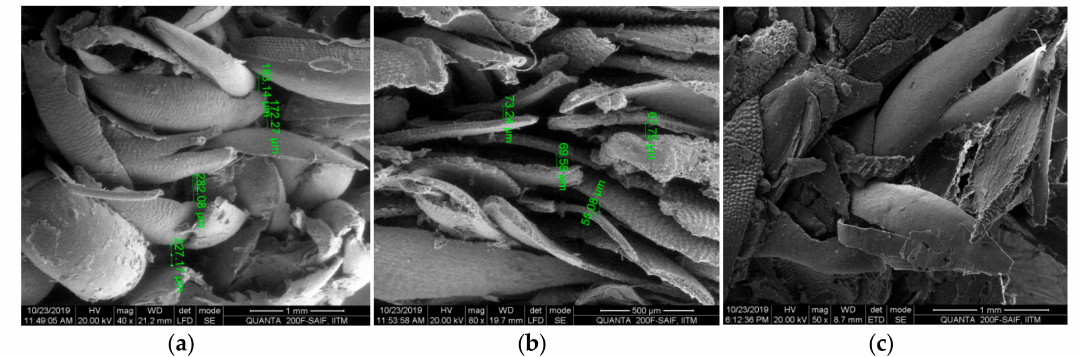
Figure 4. The SEM images of foxtail millet husk powder composites. ( a ) Composite with density 320 kg / m 3 ( b ) Composite with density 850 kg / m 3 . ( c ) Surface of the